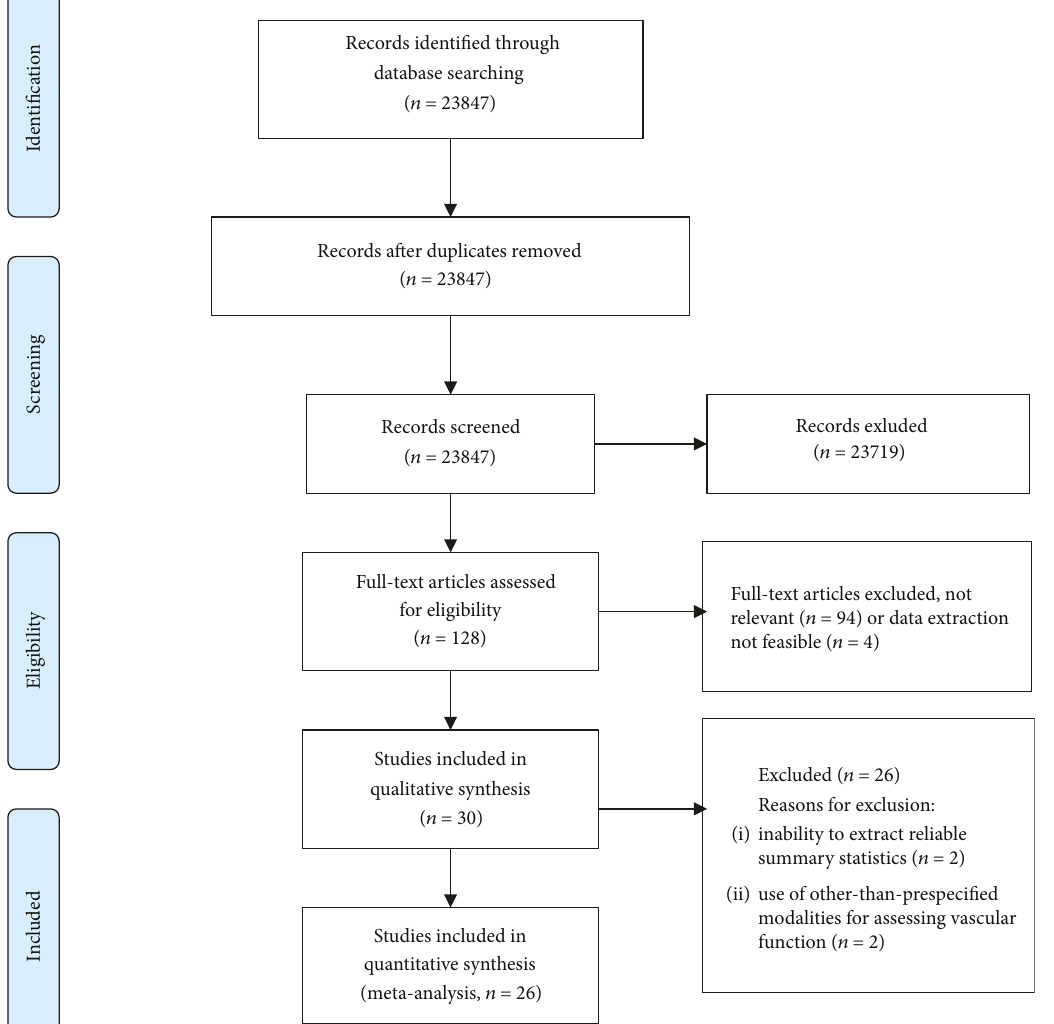
Figure 1: Study fl ow